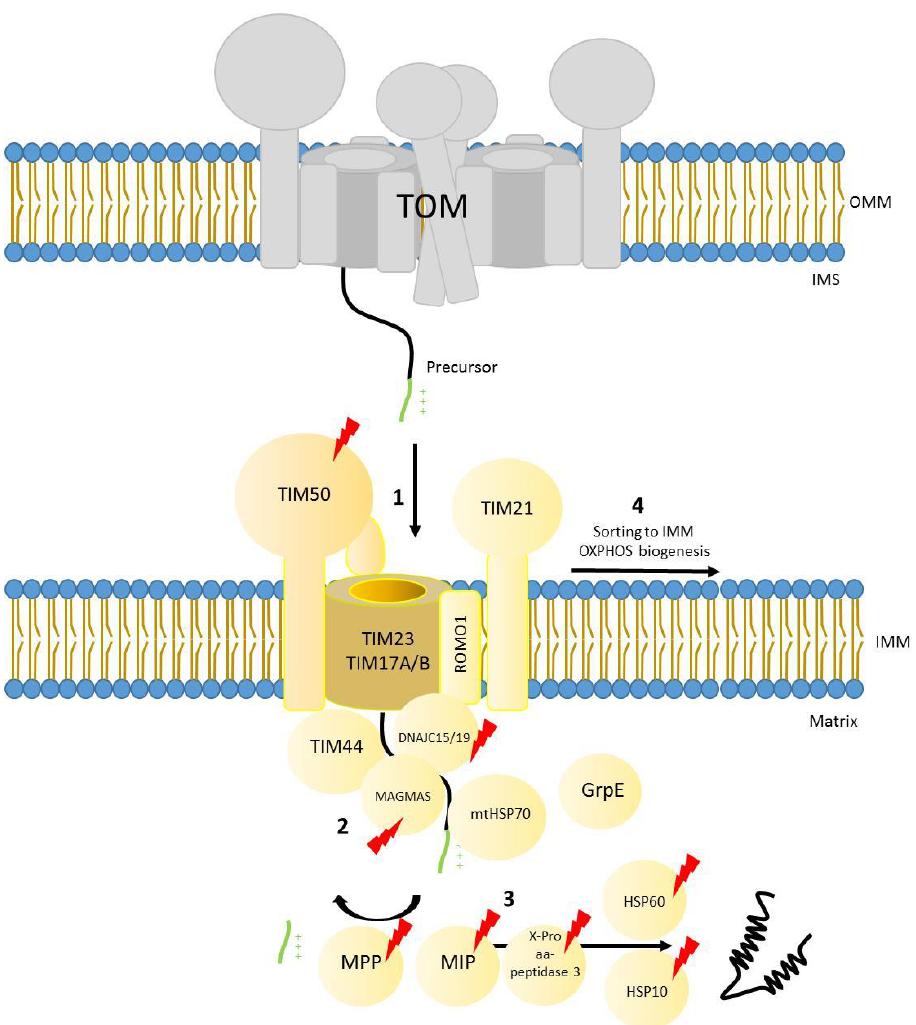
Figure 3. Scheme of translocation of mitochondrial precursors through the inner mitochondrial membrane. 1. After crossing the outer membrane through the TOM complex, presequence containing proteins are recognized by the receptors on the TIM 23 complex and directed to the channel formed by TIM23/TIM17A/B. 2. Proteins targeted to the mitochondrial matrix cross the channel partially, expose their N-terminus to the matrix and interact with TIM23 associated motor components (TIM44, MAGMAS, DNJAC15/19). The chaperone mt-HSP70 translocates the incoming polypeptide completely inside the matrix in consecutive ATP hydrolysis cycles. 3. After translocation to the matrix, presequence is removed by MPP and precursor proteins are further processed by the MIP protease and the X-Pro aminopeptidase 3. Finally, mitochondrial precursors adopt their final conformation with the assistance of the HSP60 and HSP10 complex. 4. Inner membrane proteins are sorted laterally from TIM23 complex into the lipid bilayer. Nuclear-encoded OXPHOS components are ushered by TIM21 into assembly intermediates to converge with mt-encoded subunits in the assembly process. Lightning Bolt: Subunits with known mutations associated with mitochondrial diseases. OMM, outer mitochondrial membrane. IMS, intermembrane space. IMM, inner mitochondrial membrane.